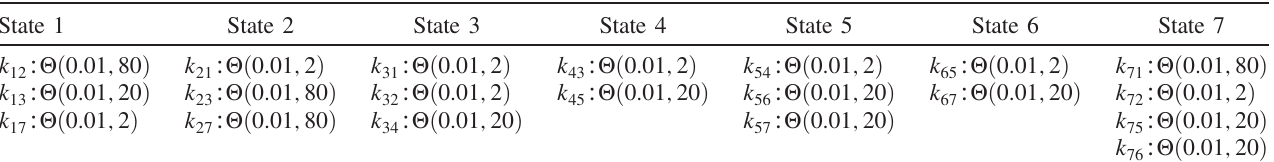
TABLE III. Distributions of the random transition rates for the multicyclic network in Fig. 3. Θ ð a; b Þ denotes a uniform distribution defined between a and b .